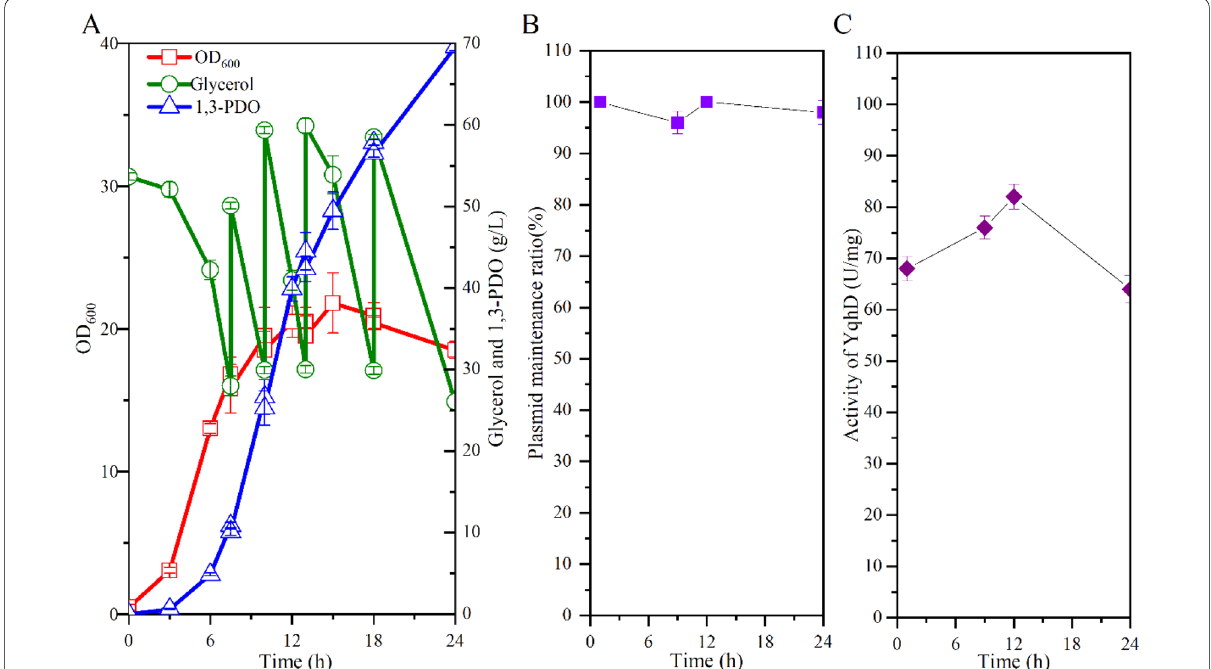
Fig. 4 Increasing the production of 1,3-PDO by strain VN13 with a plasmid stabilization system in fed-batch fermentation. A Fermentation profiles of strain VN13; B Plasmid maintenance ratio during fed-batch cultivation; C Activity of YqhD during fed-batch cultivation. No antibiotics were added in the fermentation